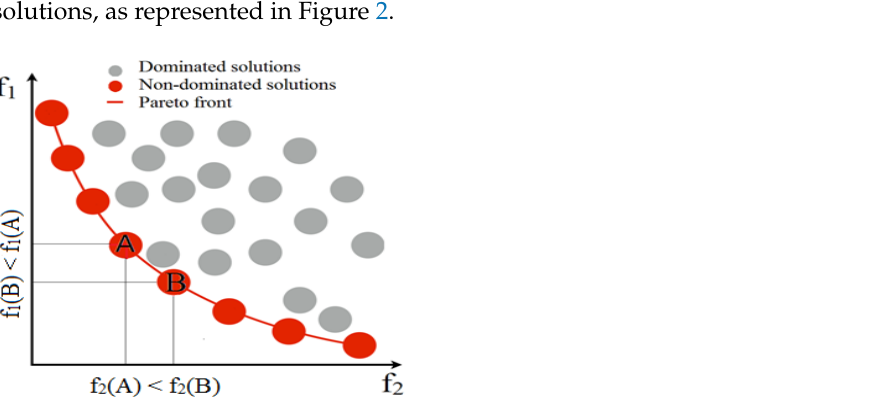
Figure 2. Dual fitness functions based on the optimal set of the Pareto front method (two examples of non-dominated solutions; A and B).